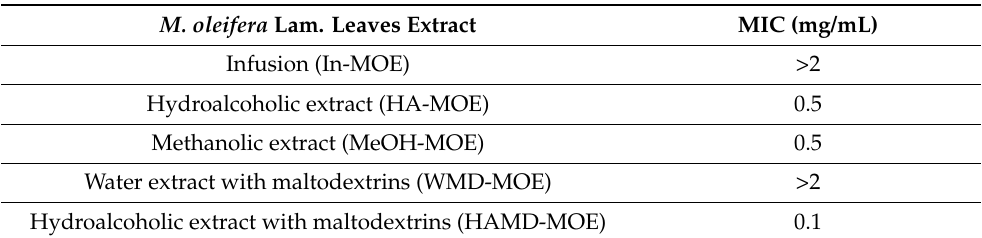
Table 4. MIC values: Each value was obtained from three different experiments performed on triplicate (mean +/ − standard deviation). No significant difference was observed for each Xcc strain, reason why the results are presented with one value for all